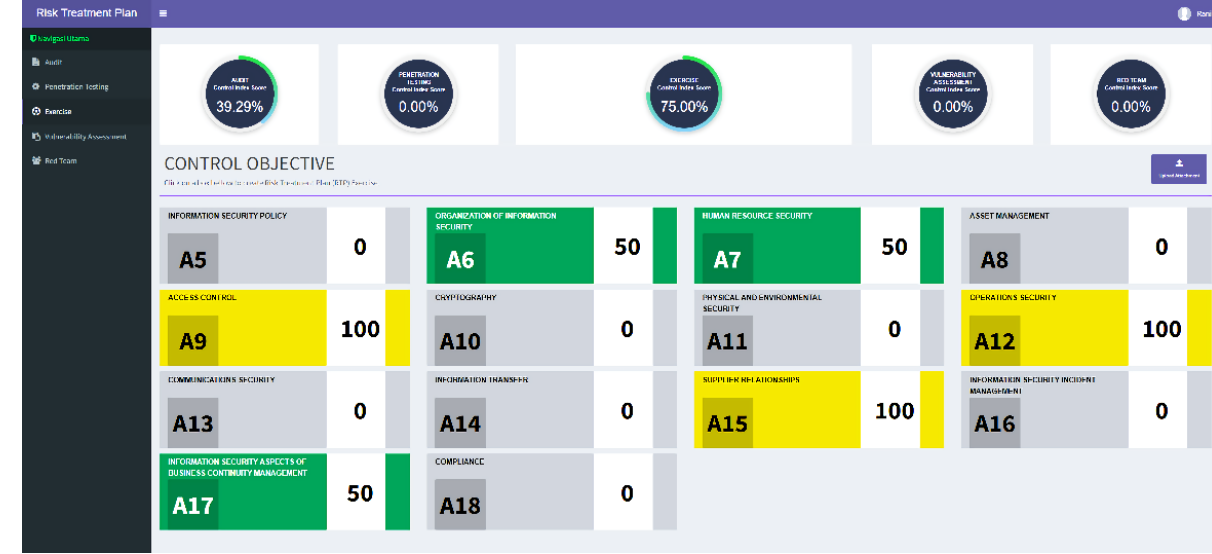
Figure 13. Visual Monitoring of Risk Control Treatment Plan of Tabletop Exercise Results. Table 6. Risk Value of Network Security Penetration Testing Findings Based on Annex ISO